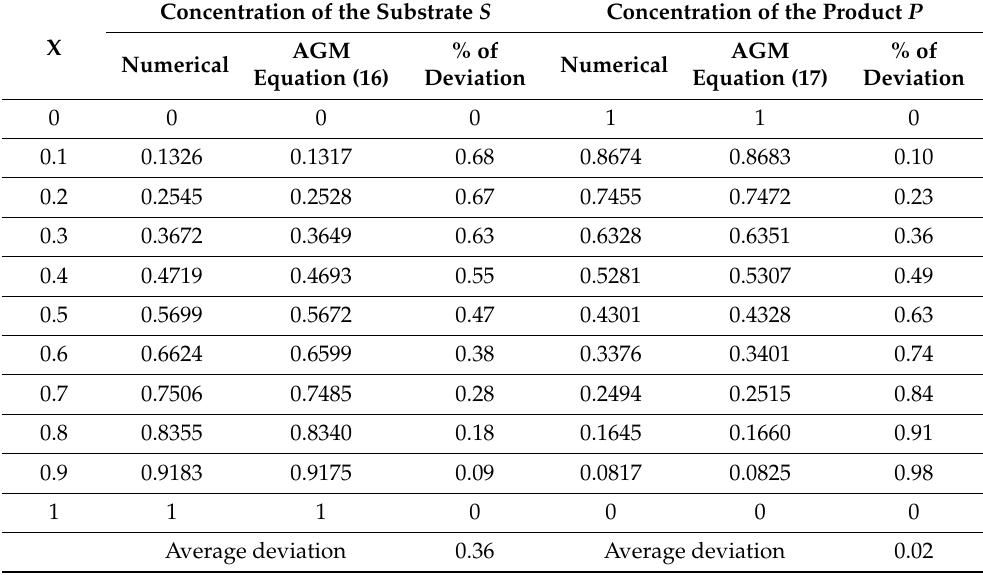
Table 1. Comparison of dimensionless concentration of the substrate S and product P with sim- ulation results for the parameter values D = 3 × 10 − 6 cm 2 10 − 8 mol , and d = 0.02 cm 3